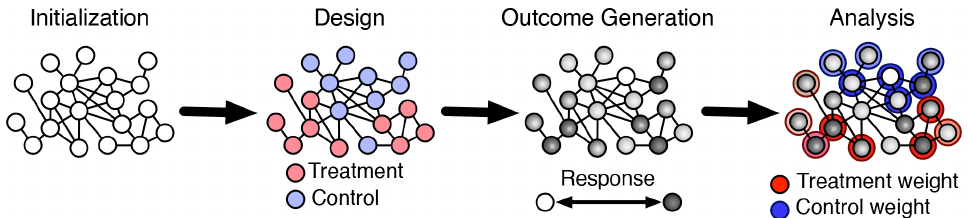
estimators under different design and analysis methods for varied initialization and outcome generation